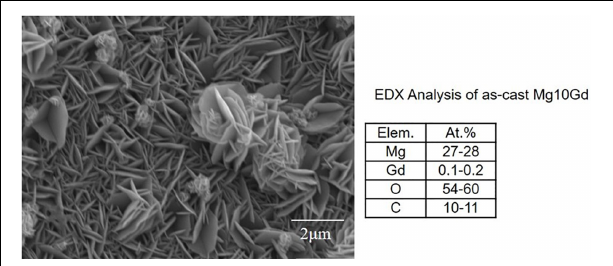
FIGURE 15 | Surface morphology of pure as-cast Mg-10Gd and EDX analysis of the oxide layer after exposure in 0.5% NaCl